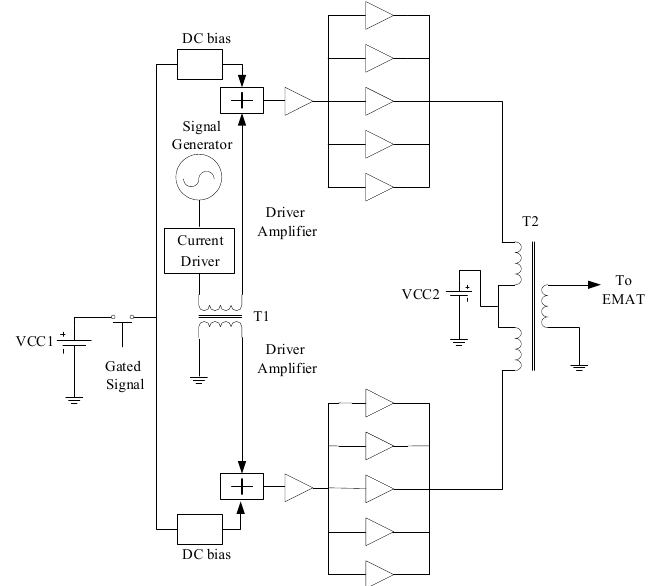
Figure 3. Gate configuration of the proposed linear PA.